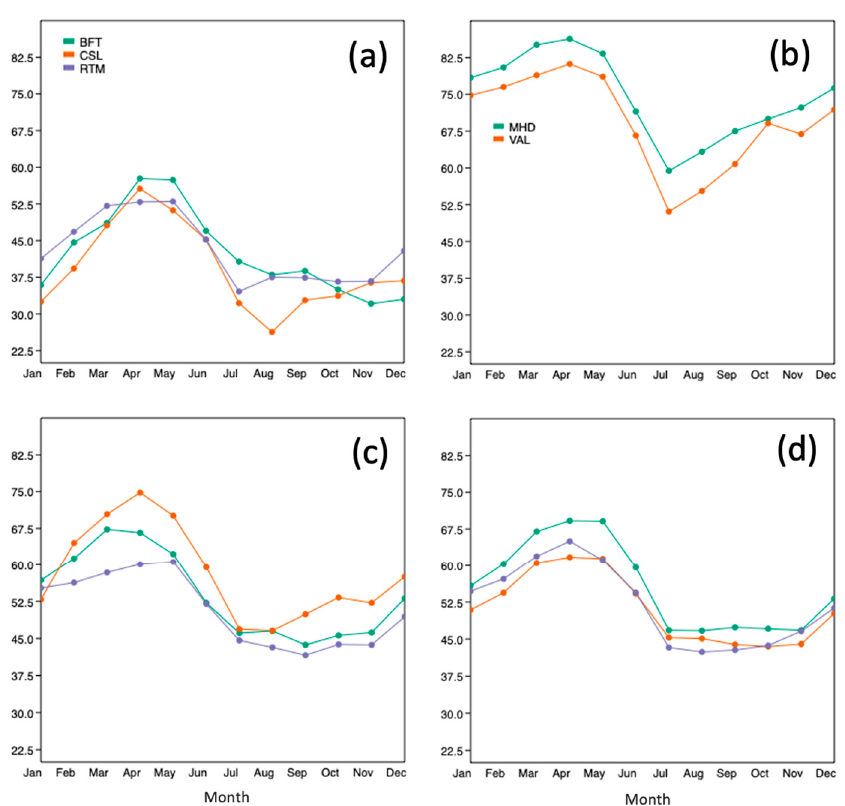
Figure 4. Five-year mean (2015–2019) monthly ozone (O 3 ) concentrations ( µ g/m 3 ) for: ( a ) urban stations (BFT, CSL, RTM); ( b ) Atlantic stations (MHD, VAL); ( c ) rural stations (EMO, KKT, LNV); and ( d ) suburban stations (CBR, CSK, SVL). See Table 1 for station ID codes.